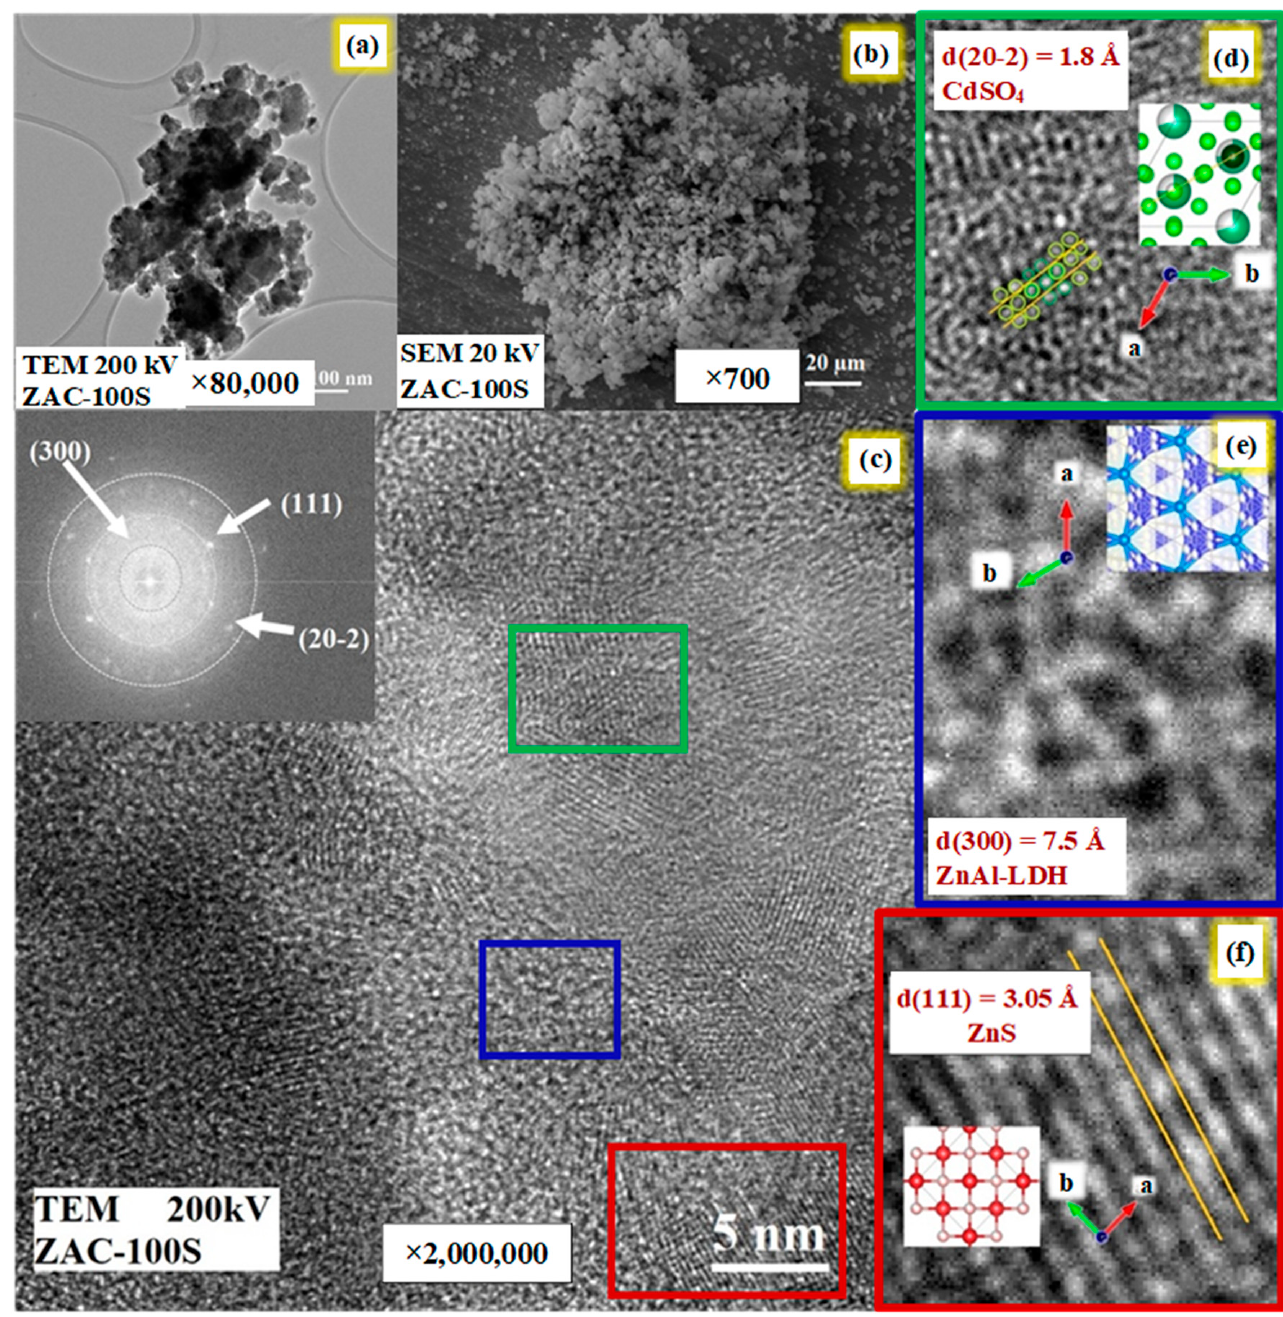
Figure 9. (a , c – f ) TEM microscopies for the sample ZAC-100S and interplanar distance determina- Figure 9. ( a , c – f ) TEM images on the ZAC-100S sample and interplanar spacing distances, ( b ) SEM tion, ( b ) SEM microscopy for the sample ZAC-100S. image of the ZAC-100S